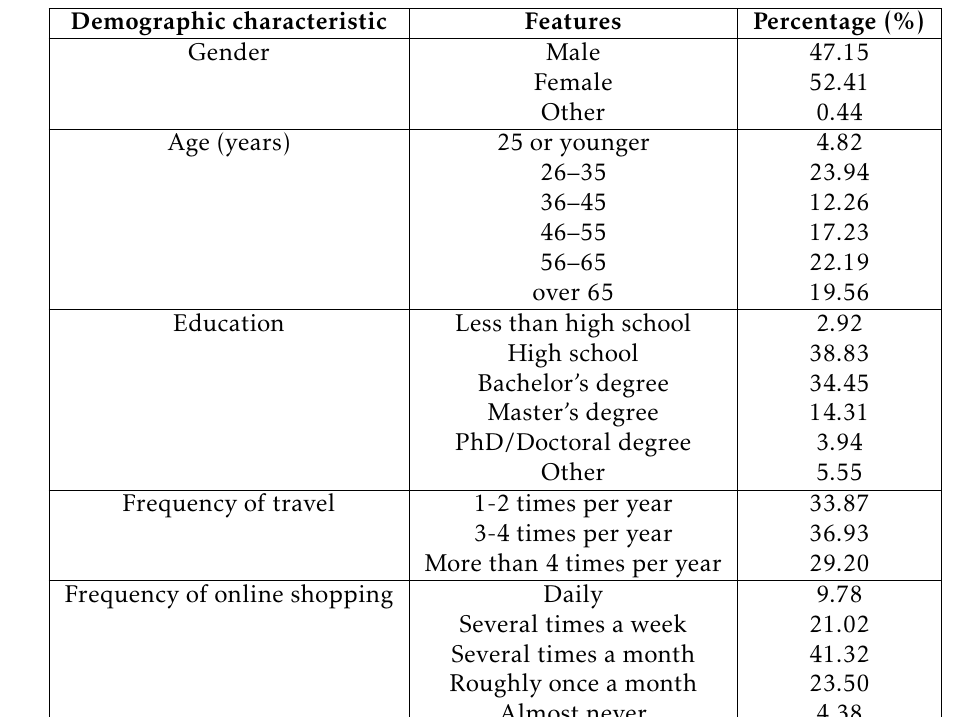
Table C.2. Demographic profiles of all human participants ( N = 685